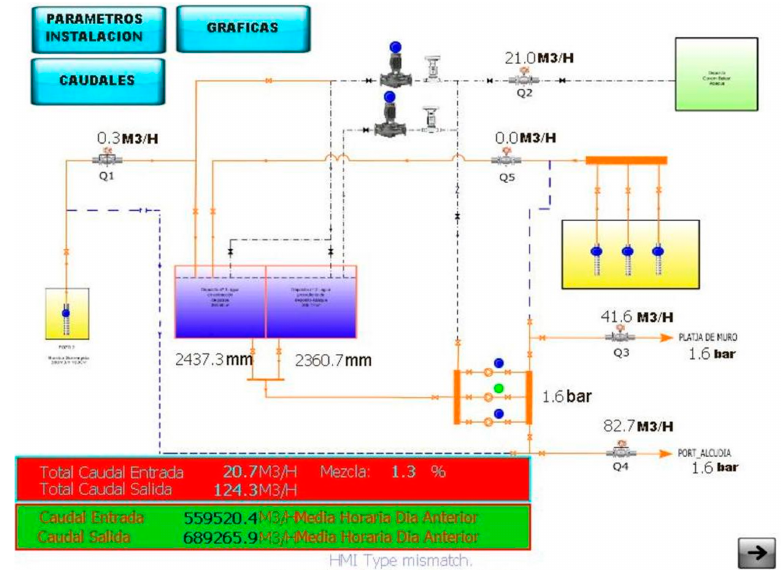
Figure A5. Screenshot of open VNC-controlled SCADA found with Shodan.